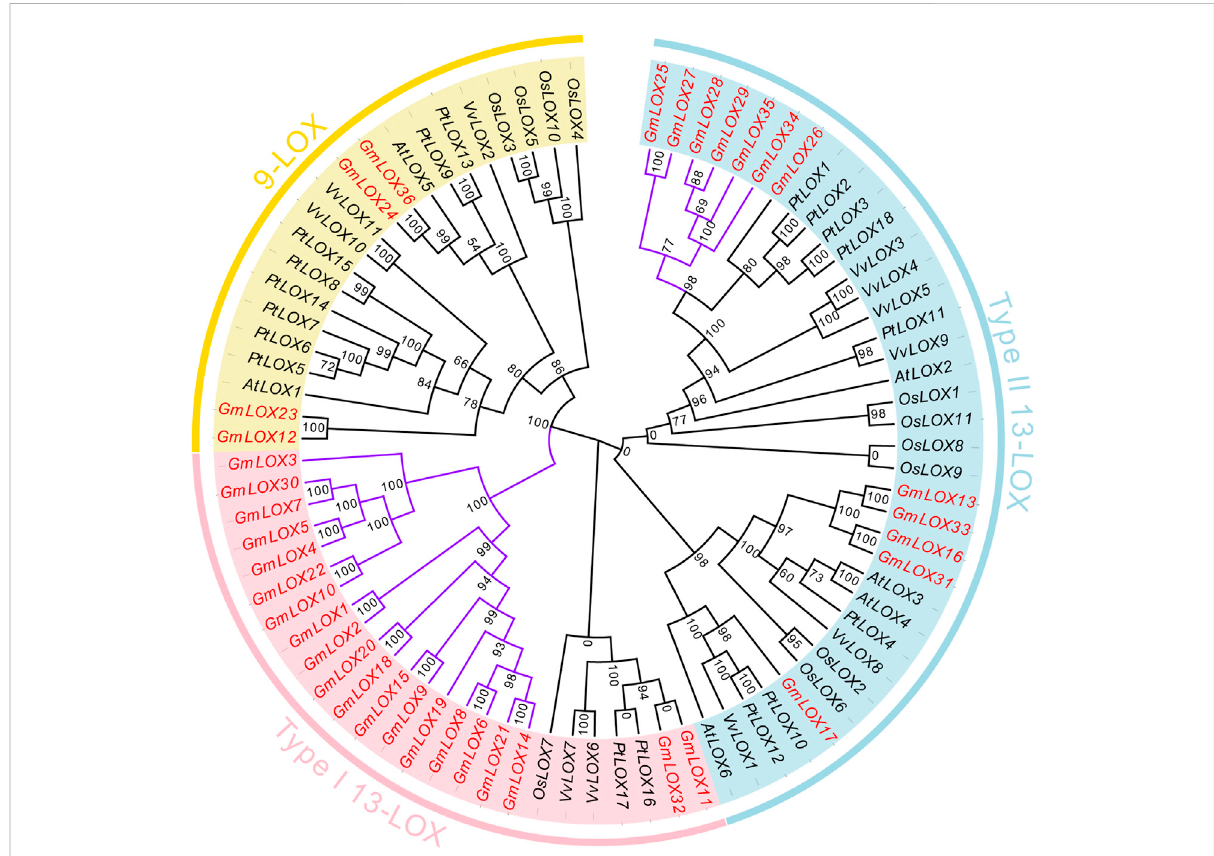
FIGURE 3 Phylogenetic analysis of GmLOX proteins in Zhonghuang 13 with other plant species Note: AtLOX: Arabidopsis thaliana . PtLOX: Populus trichocarpa . OsLOX: Oryza sativa . VvLOX: Vitis vinifera . Phylogenetic trees were constructed using the full-length amino acid sequences of LOX proteins from fi ve species by the maximum likelihood (ML) method with 1000 ultrafast bootstrap replicates, and the ultrafast bootstrap support values are indicated on each